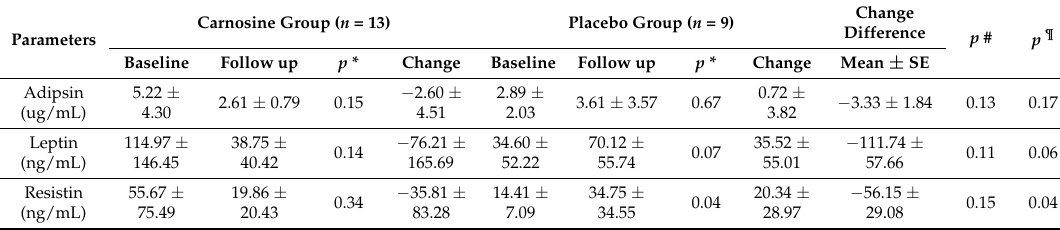
Table 1. Effect of carnosine supplementation on serum adipokine concentrations.